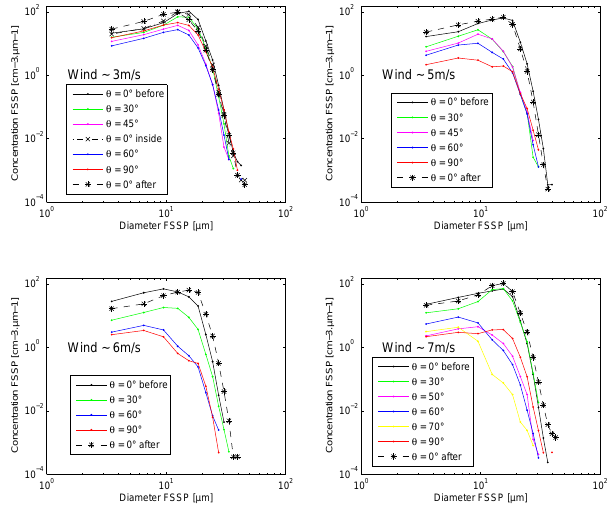
Figure 12. FSSP size distribution averaged for each angle θ corre- sponding to the angle between the wind direction and the instrument orientation, for the four manipulations. The averaged wind speed is indicated for each